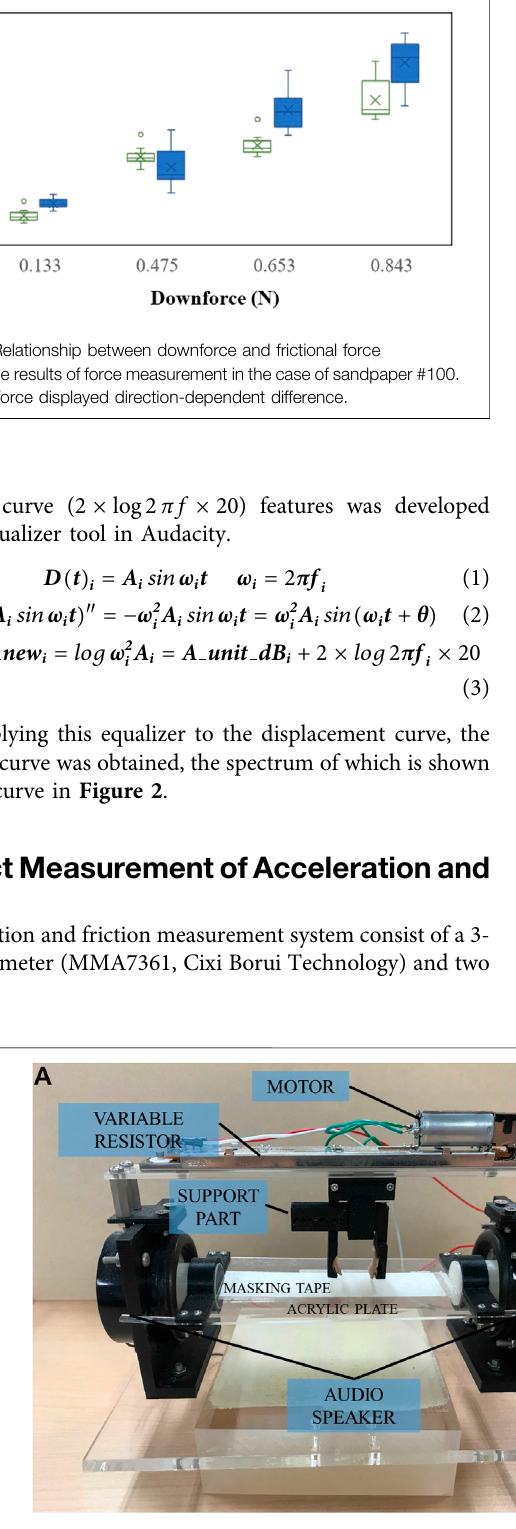
Frontiers in Virtual Reality |